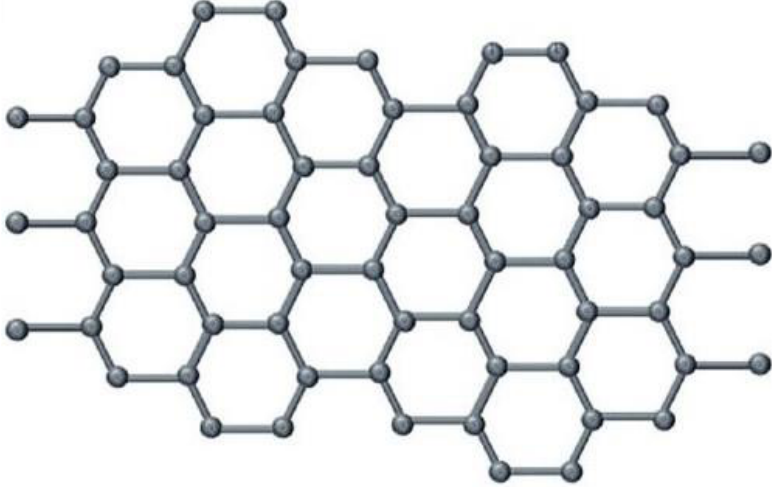
Figure 1. Typical structure of monolayer graphene [44]. (Adapted with permission from ref. [44]. Copyright 2020 IntechOpen.)